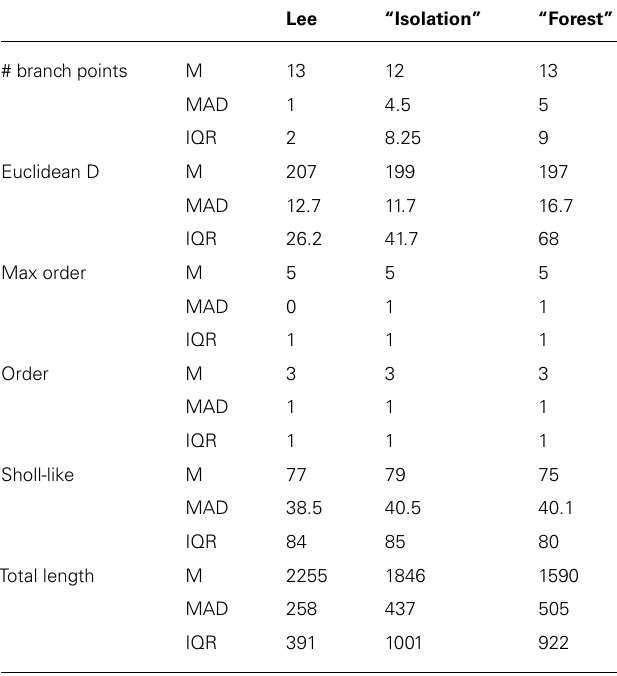
Table 4 | Quantitative description of experimentally reconstructed hippocampal granule neurons and their generated counterparts. Lee “Isolation”